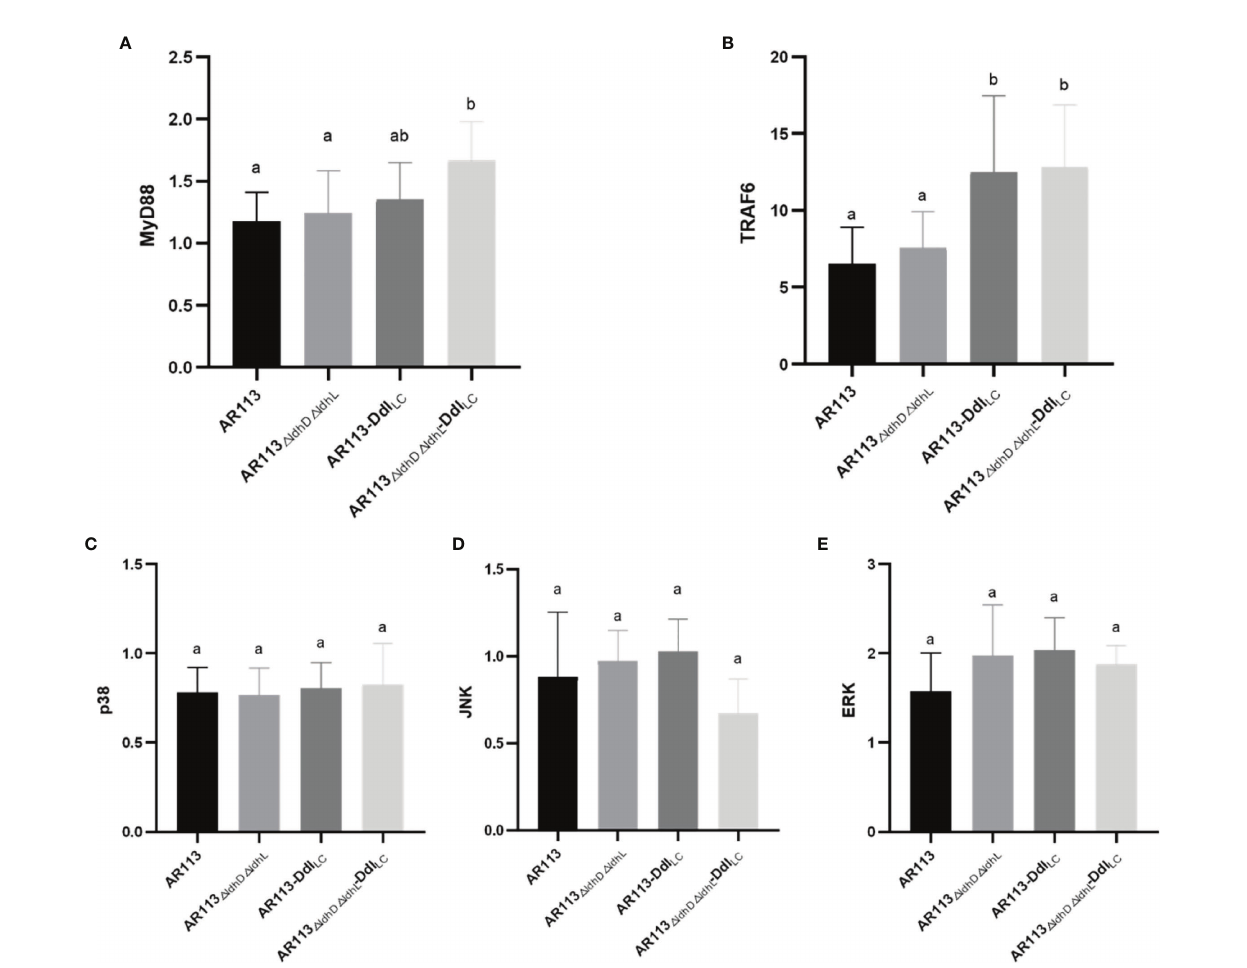
FIGURE 4 | Analysis of the immunomodulatory signaling pathway affected by Ddl-overexpressed strains. (A) MyD88; (B) TRAF6; (C) p38; (D) JNK; (E) ERK. The statistical analyses were assessed using one-way ANOVA. Data are represented as means ± standard deviations (n = 7). Data indicated with different letters differ signi fi cantly (P <